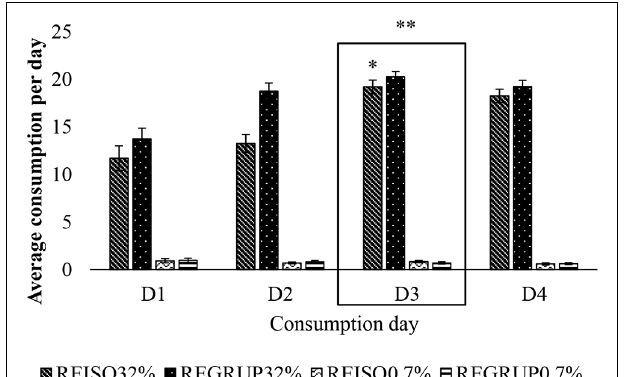
FIGURE 4 | Average consumption of 32% sucrose solution vs. 0.7% sucrose solution on D1, D2, D3, and D4 after exposure to 72 h of resocialization. Average consumption (PROM ± EE) of 32% SS vs. 0.7% SS on D1, D2, D3, and D4, in the groups REISO32% (Grouped animals that became isolated 32%); REGRUP32% (Isolated animals that became grouped 32%); REISO0.7% (Grouped animals that became isolated 0.7%); and